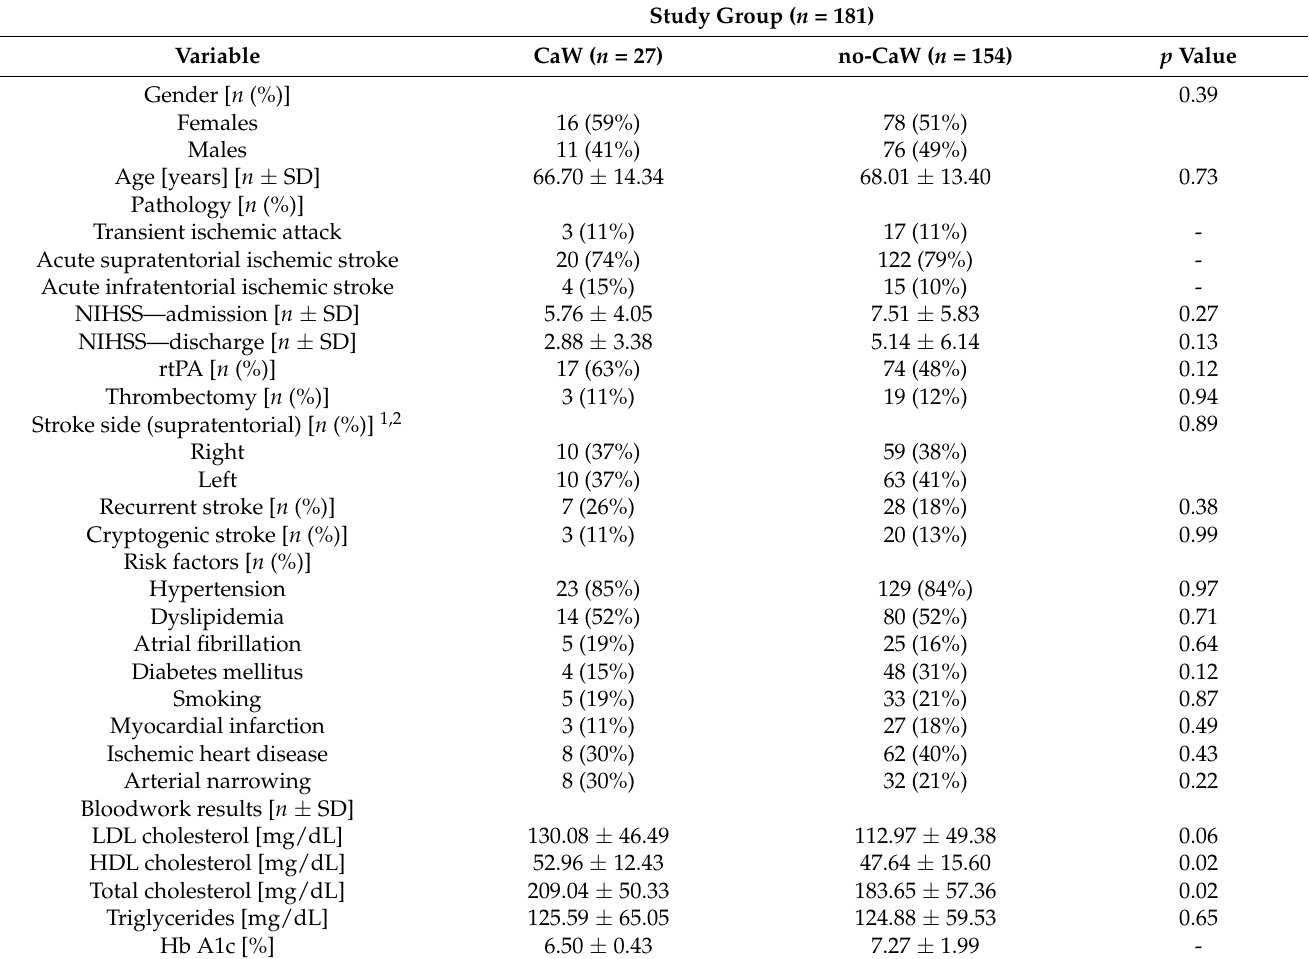
Table 1. Demographic, clinical and laboratory characteristic of a final analyzed post-stroke and TIA group.